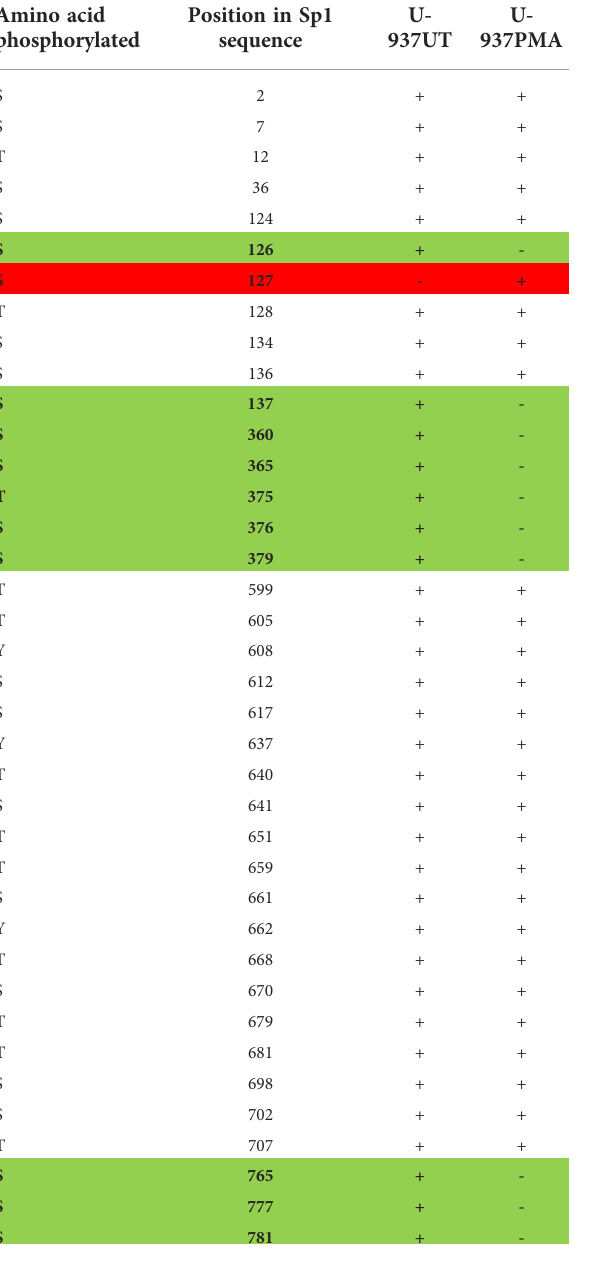
TABLE 2 PTM (phosphorylation) analysis on Sp3 in promonocytic U-937 cells upon PMA stimulation.